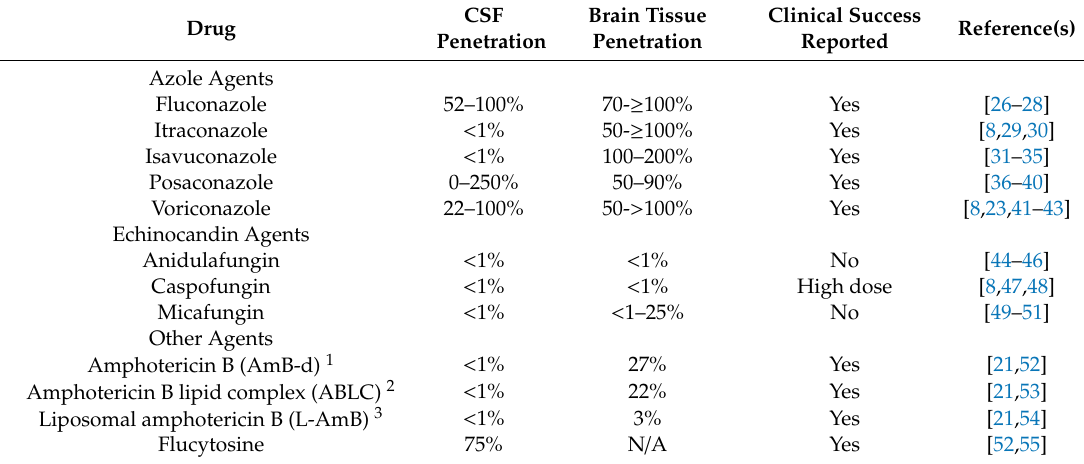
Table 2. Antifungal drug penetration in the central nervous system (as % of serum